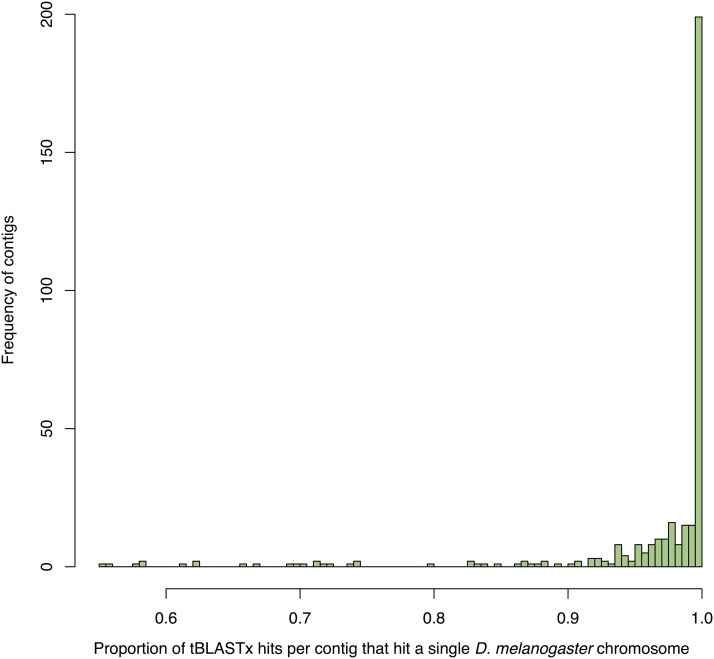
Comparison of D. serrata gene locations relative to D. melanogaster. On average, > 95% of tBLASTx hits to D. melanogaster genes (version 6.05) in each contig map to a single D. melanogaster arm.